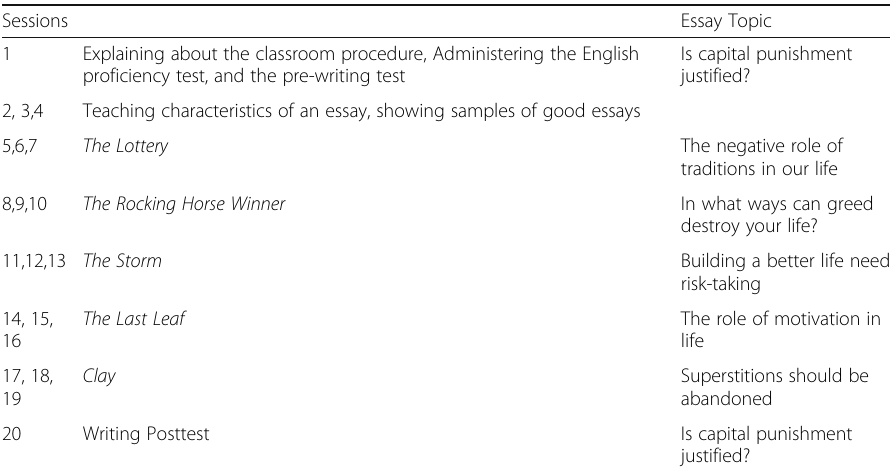
Table 2 Short stories and writing